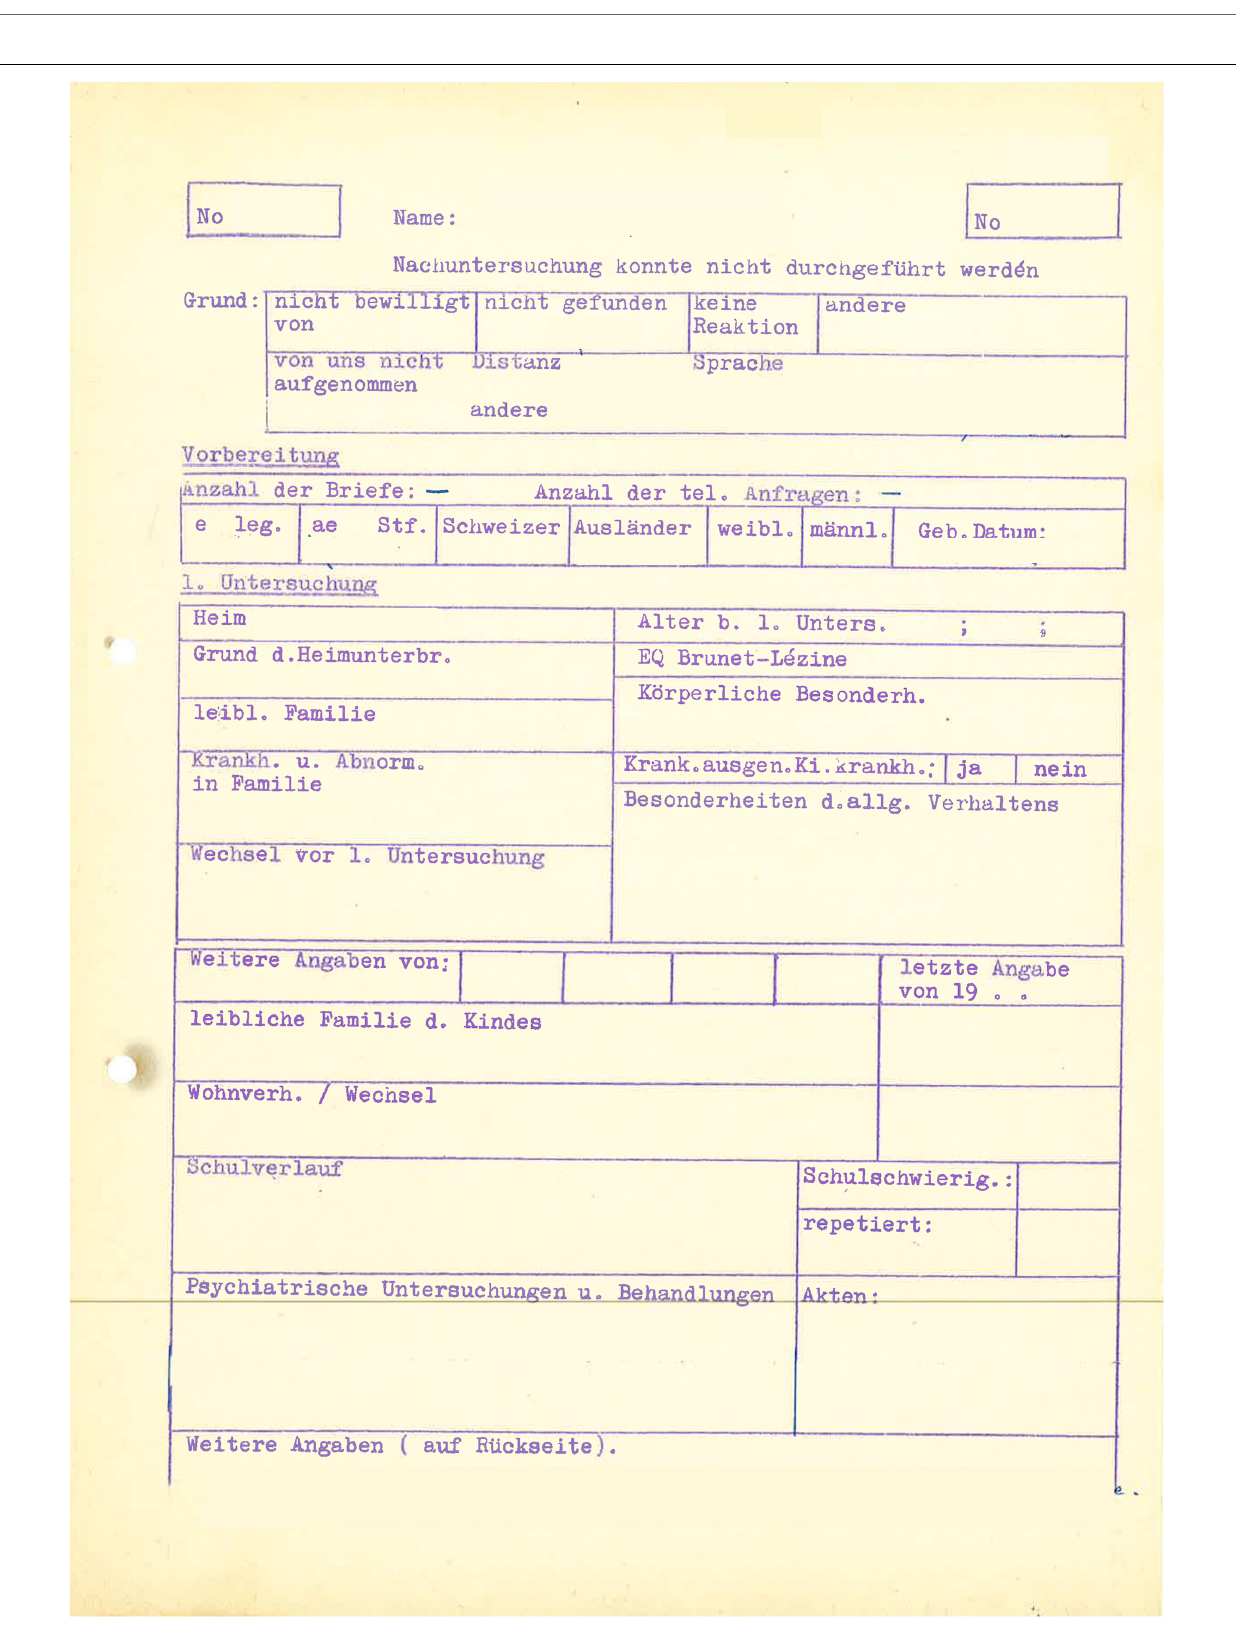
FIGURE 4 | Example of person-centered data (Wave